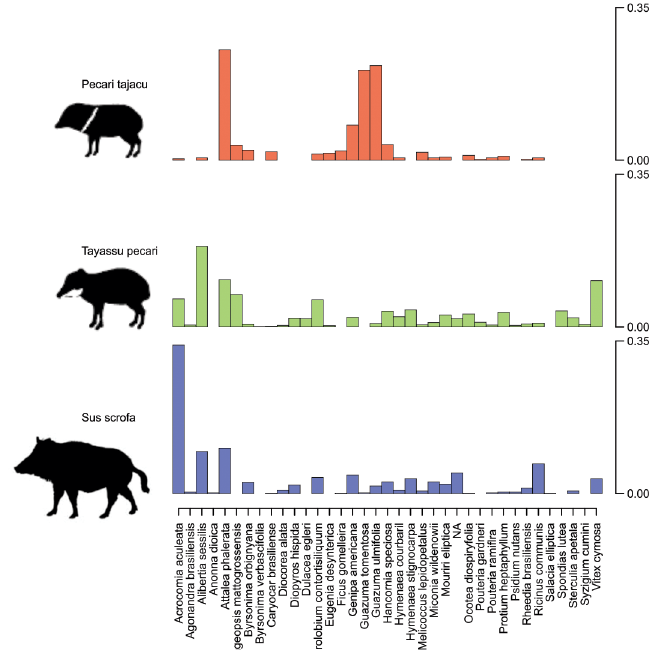
Fig 3. Diet overlap of fruits among white lipped and collared peccaries ( Pecari tajacu , Tayassu pecarie ), and feral pigs ( Sus scrofa ) in the Brazilian Pantanal. Each bar represents the proportion of independent photos taken for each plant